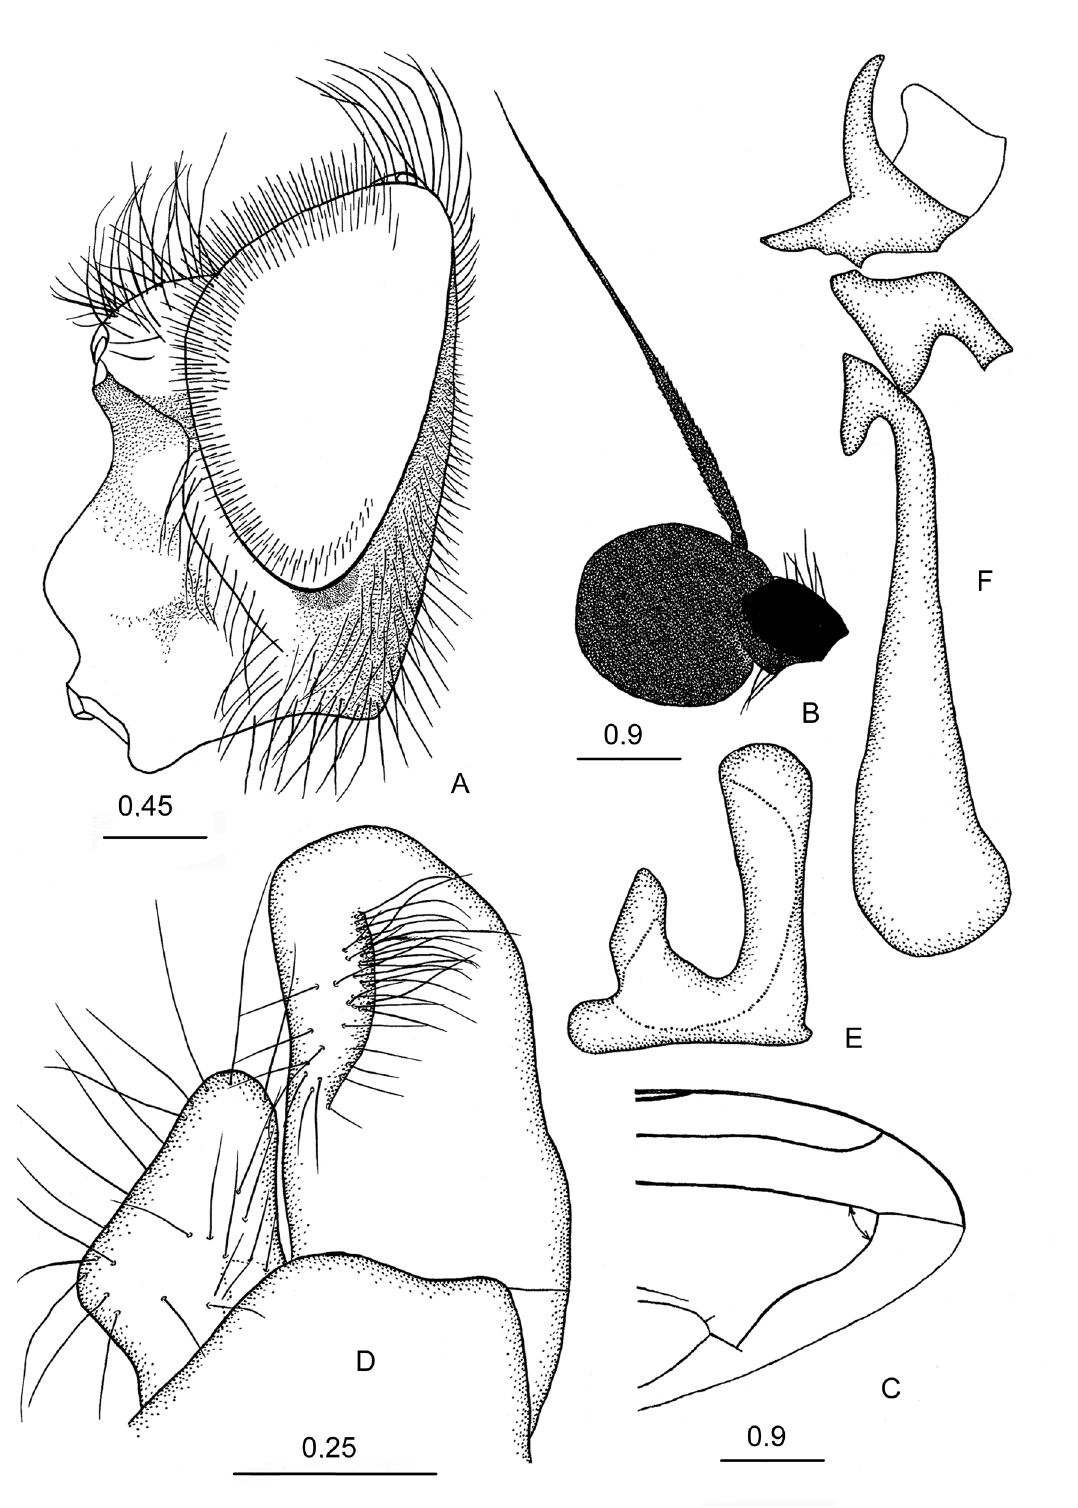
Fig. 33. Cheilosia ( Floccocheila ) indistincta sp. nov., holotype, ♂ (IBSJW/NME). A . Head, lateral view. B . Antenna, lateral view of pedicel and basoflagellomere. C . Tip of wing. D . Surstylus and gonocercus, lateral view. E . Superior lobe of hypandrium, lateral view. F . Aedeagus and aedeagal apodeme, lateral view. Scale bars indicated in